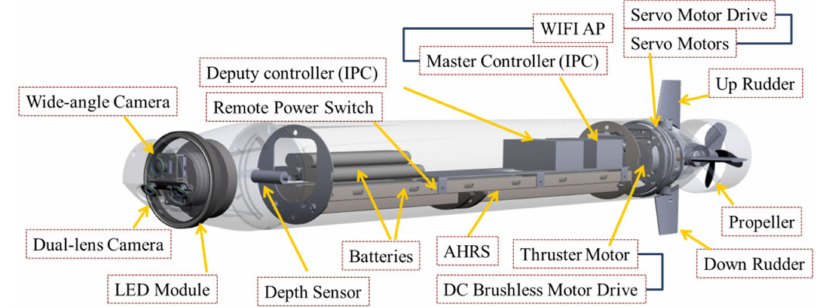
Figure 1. Interior structure of the AUV.